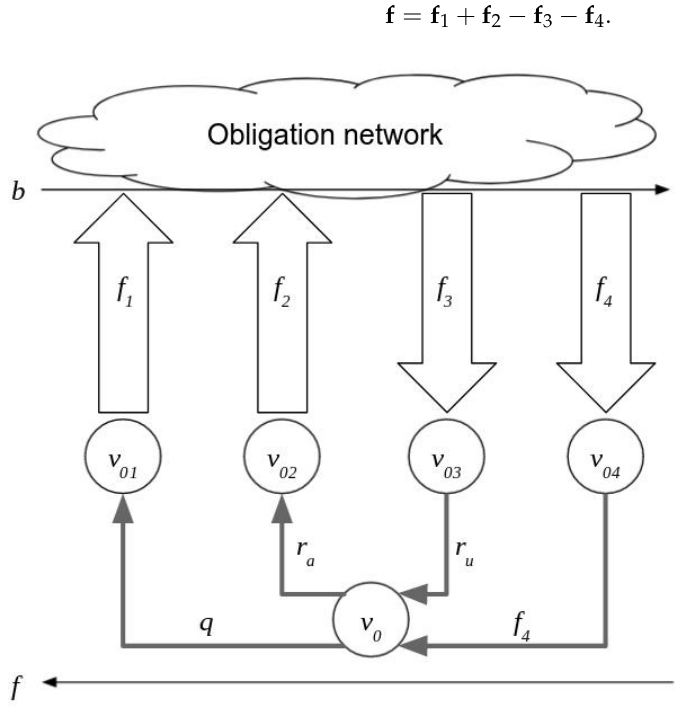
Figure 9. A payment system with firms’ accounts and an overdraft